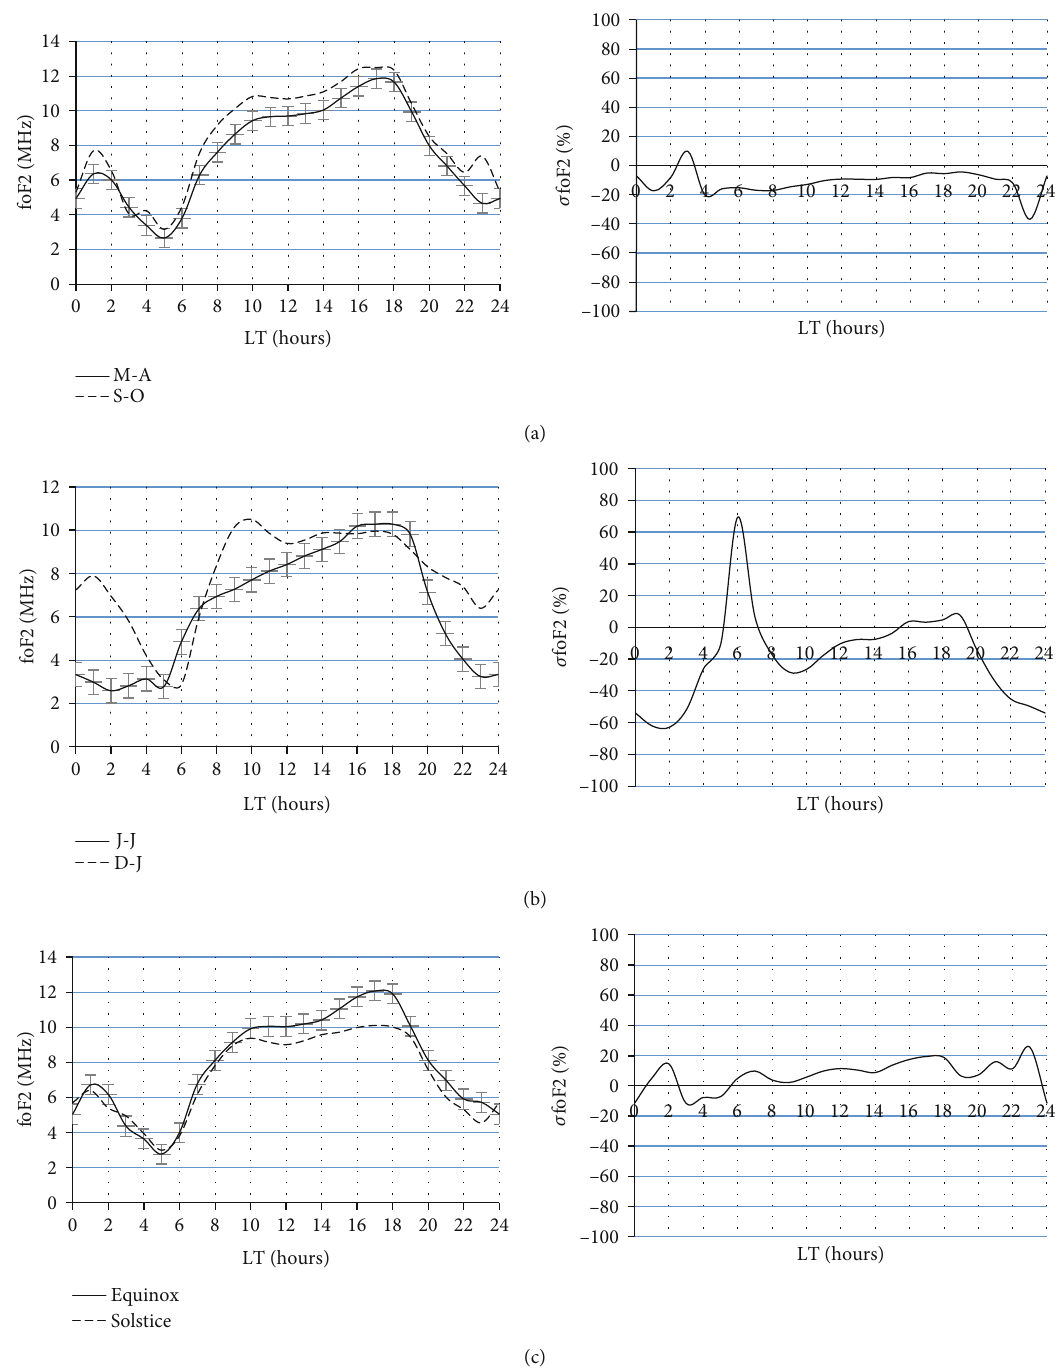
Figure 2: The same as Figure 1 but for the solar cycle increasing